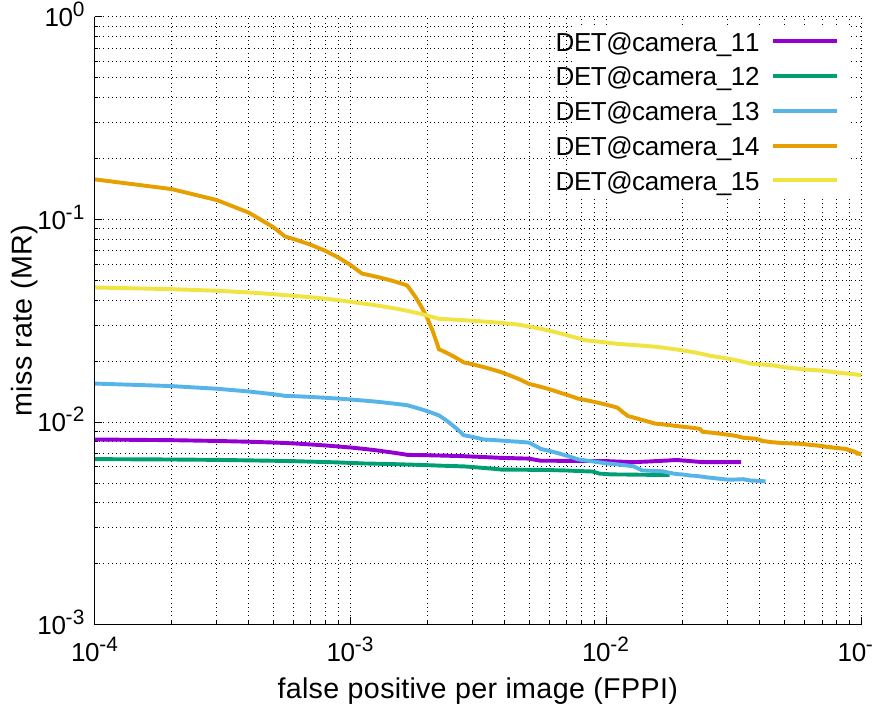
Figure 18. DET curves @ Cameras_11–15, informed-filters.